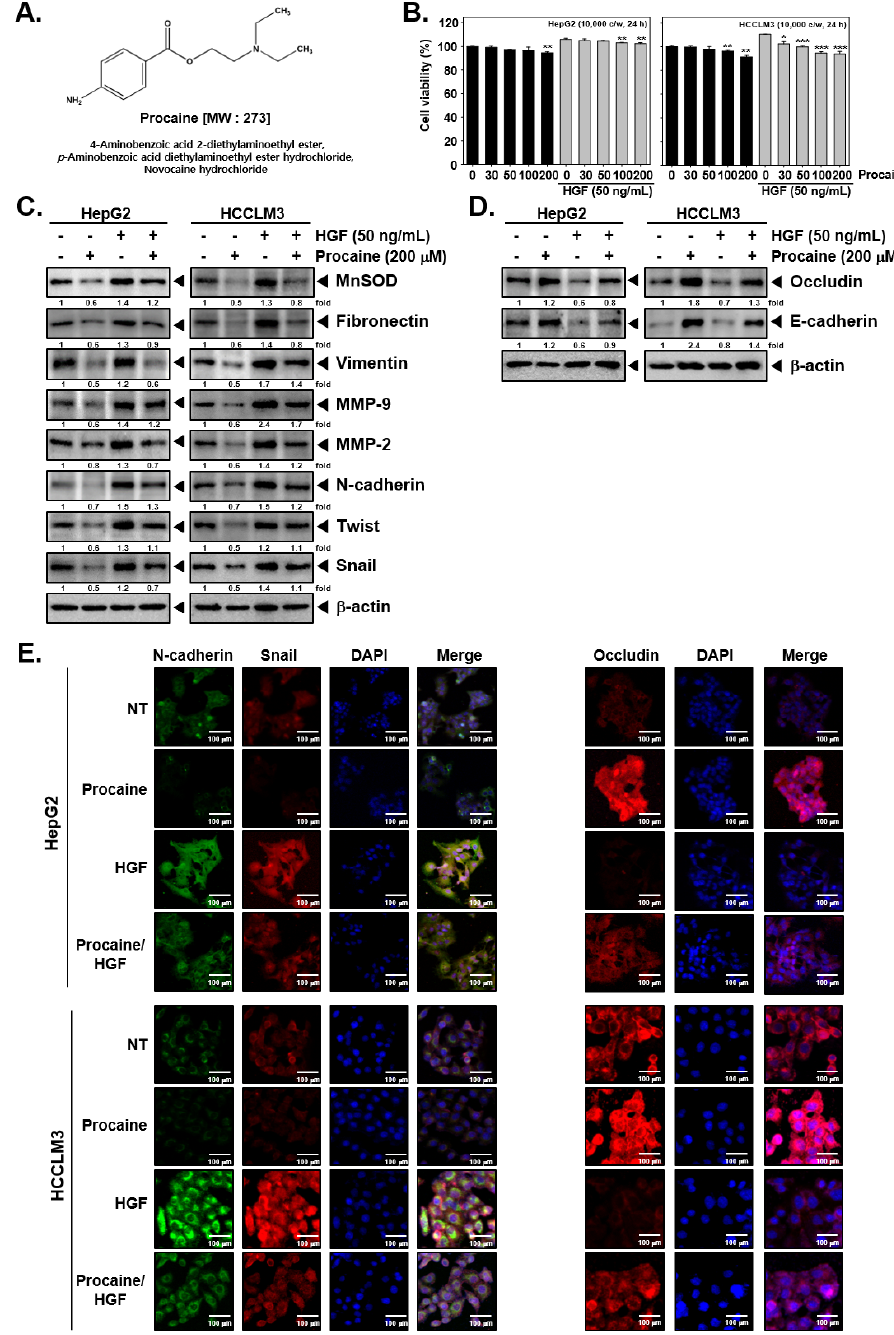
Figure 1 . Impact of procaine on EMT markers. ( A ) The structure of procaine. ( B ) HepG2 and HCCLM3 cells were pre-treated with procaine (0, 30, 50, 100, 200 μ M) for 2 h, followed by treated with procaine and HGF (50 ng/mL) for a total 24 h and cell viability was measured. Data represent means ± SD. * p < 0.05 vs. non-treated (NT) cells ** p < 0.01 vs. non-treated (NT) cells, *** p < 0.001 vs. non-treated (NT) cells. ( C , D ) HepG2 and HCCLM3 cells were pre-treated with procaine (200 μ M) for 2 h and treated with procaine and HGF (50 ng/mL) for a total 24 h, and western blotting was performed. ( E ) HepG2 and HCCLM3 cells were exposed to HGF and/or procaine as indicated in